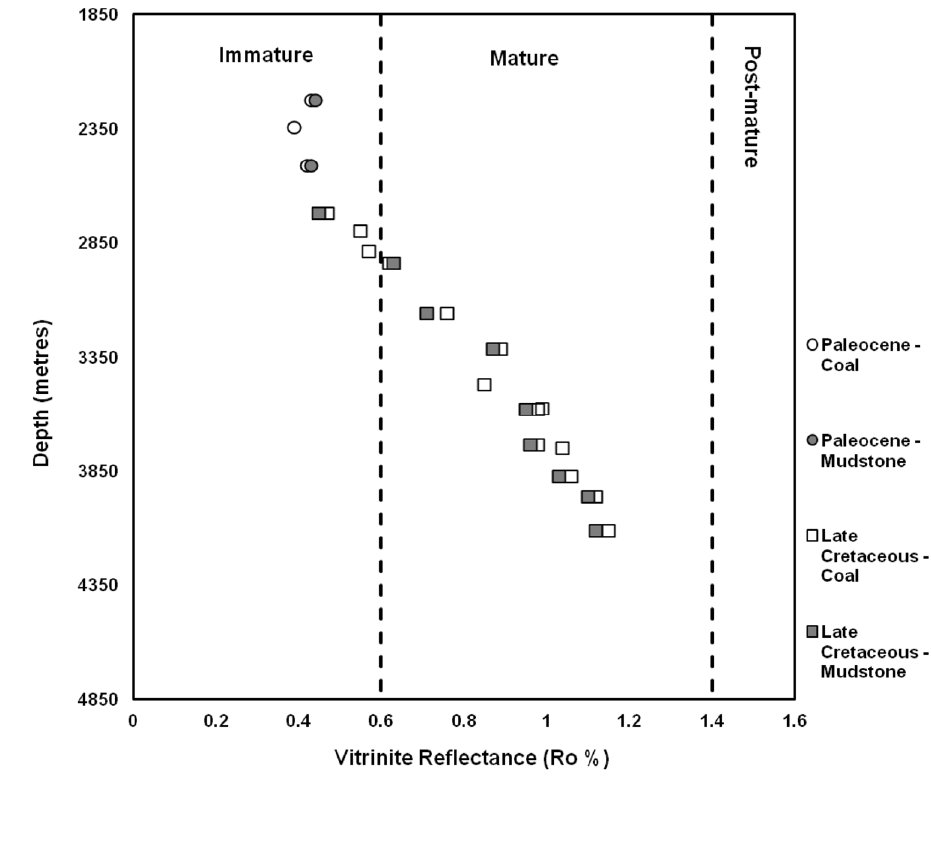
Fig. 11 A cross-plot of vitrinite reflectance (% R o ) versus depth to demonstrate the distribution of the parameter with increas- ing depth